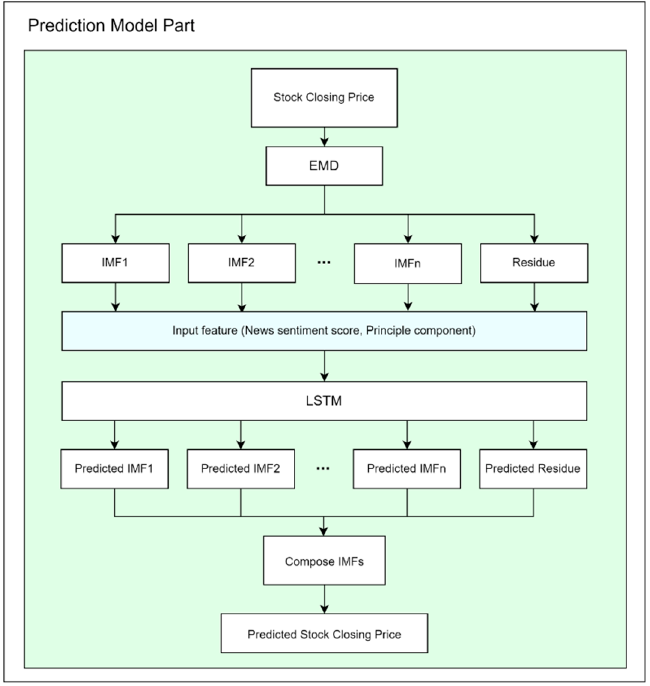
Figure 6. The process of the prediction model.